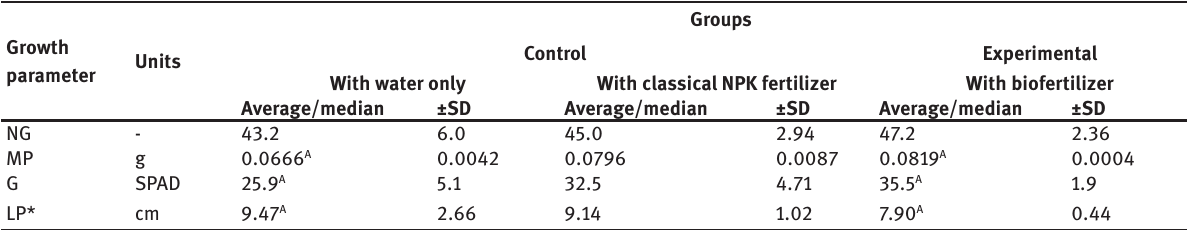
Table 3: Differences between cress growth parameters in germination tests; LP - length of plant,cm, G - intensity of green color, SPAD, MP – the mass of plants, g, NG - the number of germinated seeds